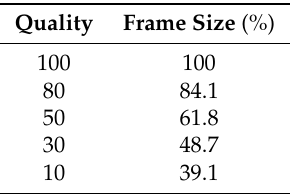
Table 2. Encoding quality vs. frame